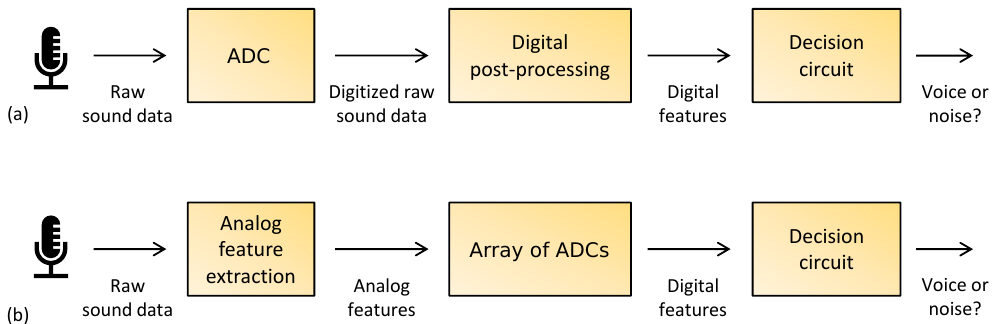
Figure 1. Speech recognition/Voice-Activity-Detector (VAD) approaches: ( a ) digital features extraction; and ( b ) analog features